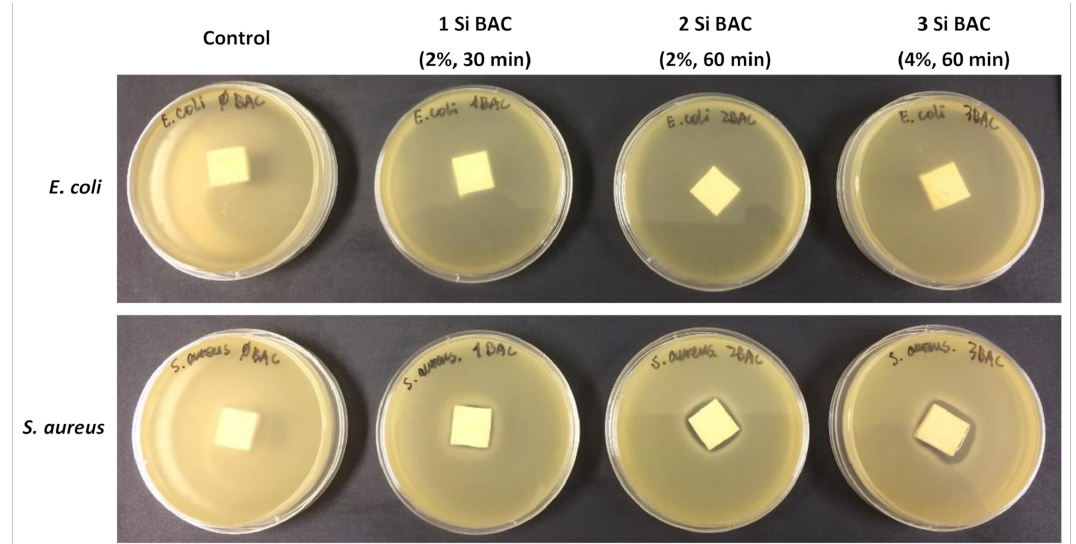
Figure 3. Antibacterial activity of the BC composites surface functionalized with benzalkonium chloride-based product against Escherichia coli and Staphylococcus aureus